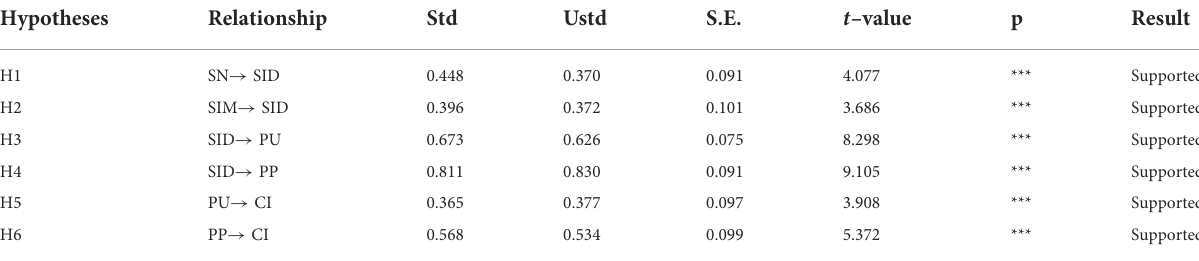
TABLE 6 Path coefficients and hypothesis